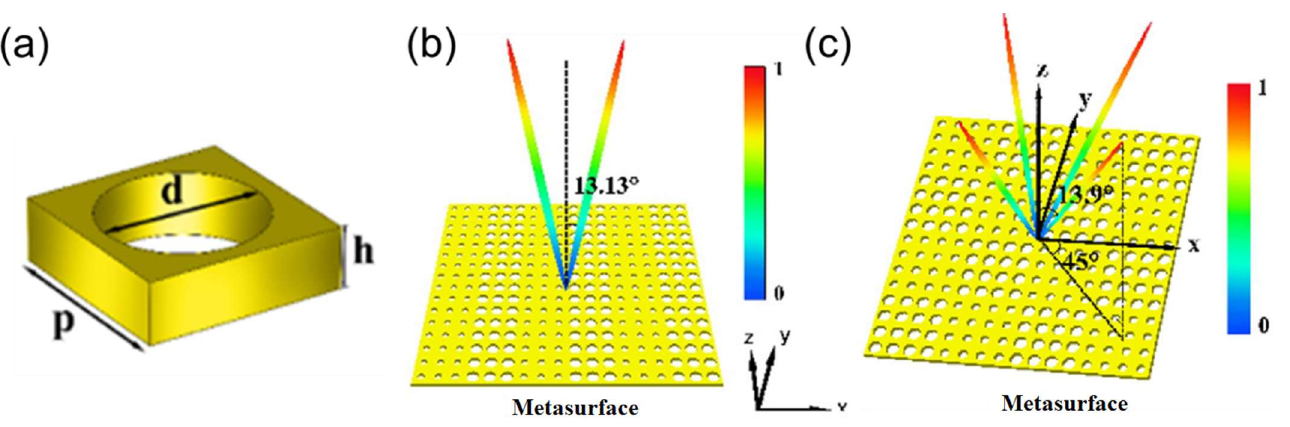
Figure 14. ( a ) Coding cell structure consisting of two ELC structures and a metal ground patch sep- arated by two polyimide layers [128]. Copyright 2016 John Wiley and Sons ( b ) The coding sequence S2 of 72 × 72 coded particles, 2D scattering simulation pattern at 0.78 THz ( i ) and 1.19 THz ( ii ) [128]. Copyright 2016 John Wiley and Sons. ( c ) Schematic diagram of the PB-encoded metasurface unit. Reprinted with permission from [130]. Copyright 2017 American Chemical Society. ( d ) Controlling multiple scattered beams and polarizations through convolution operations. “∗” stands for convo- lution. Reprinted with permission from [130]. Copyright 2017 American Chemical Society. ( e ) Sche-